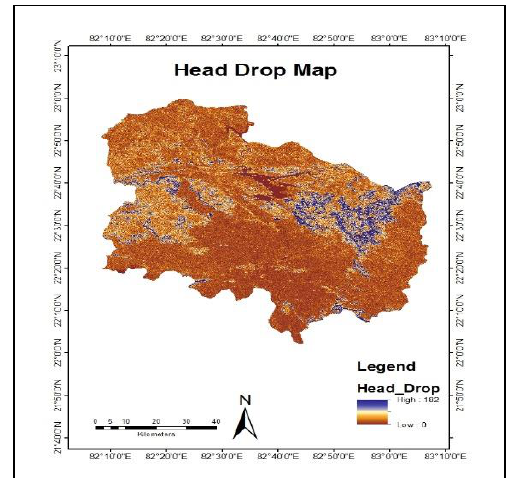
Figure 6. Head drop/Falling height map